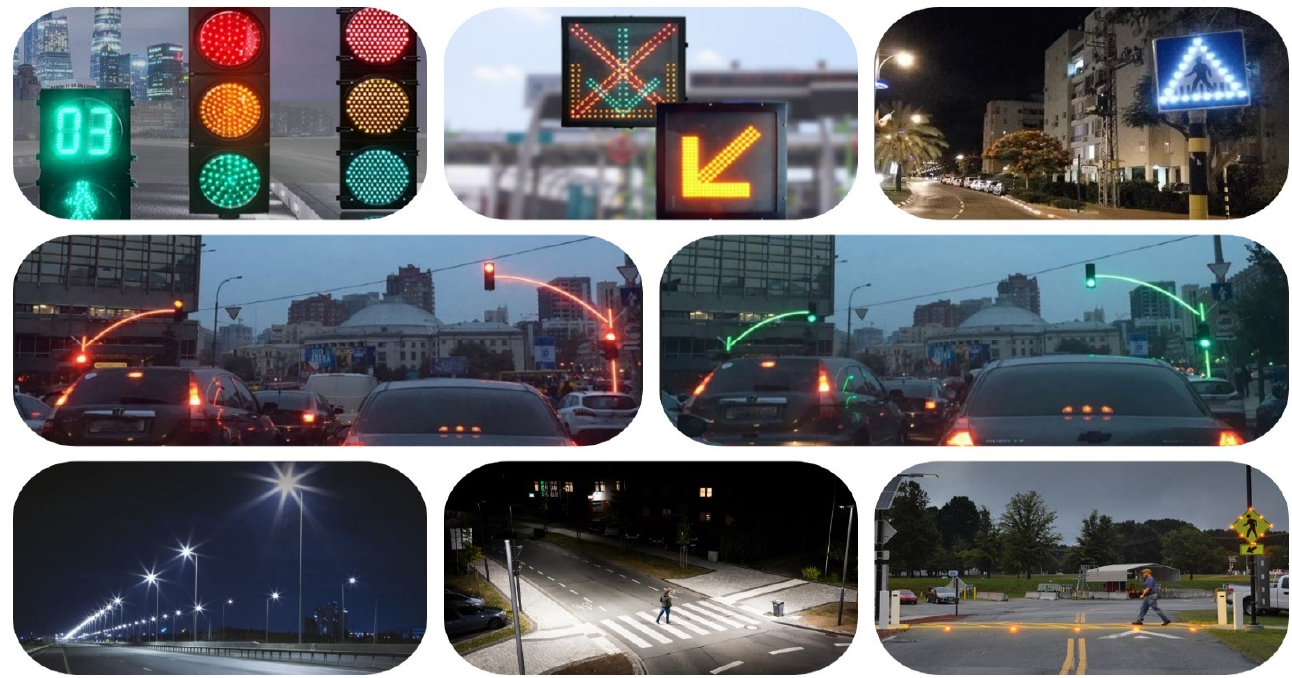
Figure 1. LED lighting sources installed in road and pedestrian infrastructures, capable of providing communications through visible light and optical camera communications.